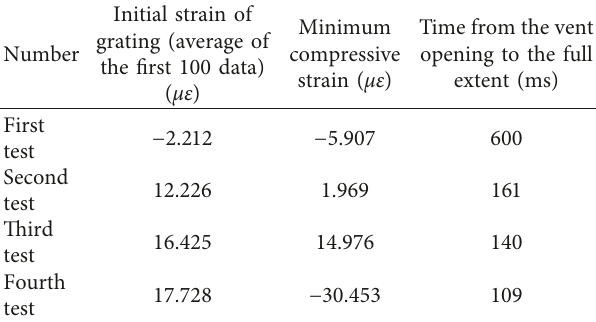
Table 5: Comparison of the overpressure strain results of the four